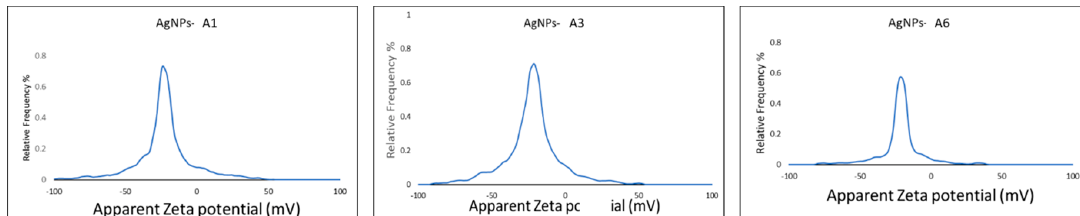
Figure 5. Zeta potential of azoles after conjugation with silver nanoparticles. Peaks can be observed at low millivolts suggesting successful conjugation and formation of small particles.